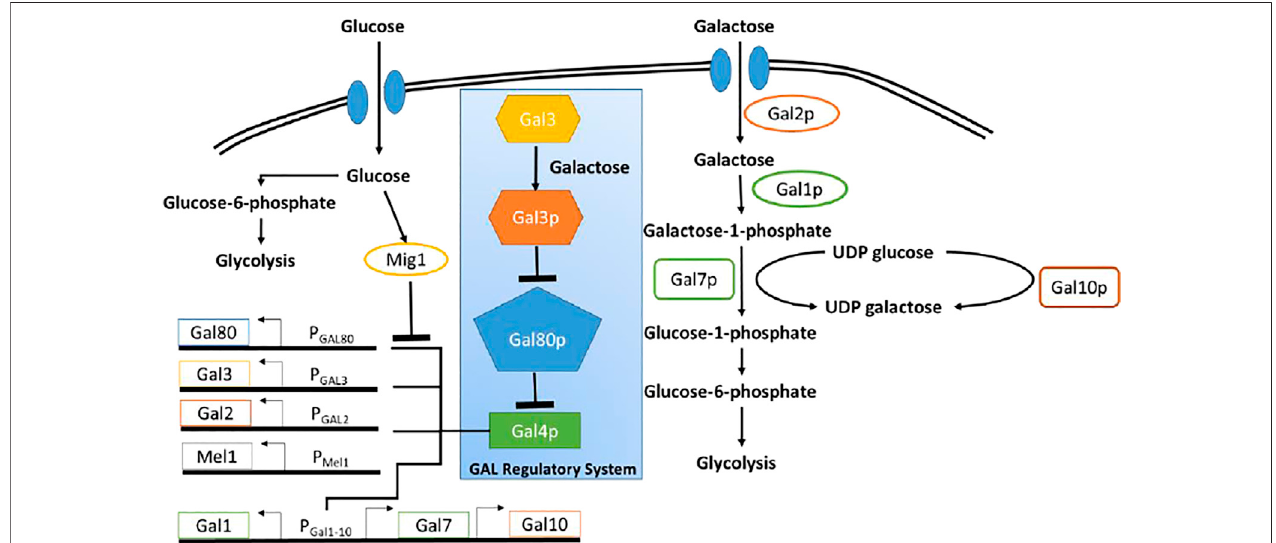
FIGURE 1 | Schematic of galactose and glucose metabolic pathway in Yeast. Blue box highlighted the regulatory network pathway of GAL genes. Glucose as a primary carbon resource, suppress the GAL genes through Mig1 protein. In the presence of galactose and in the absence of glucose, GAL4 protein activates the GAL